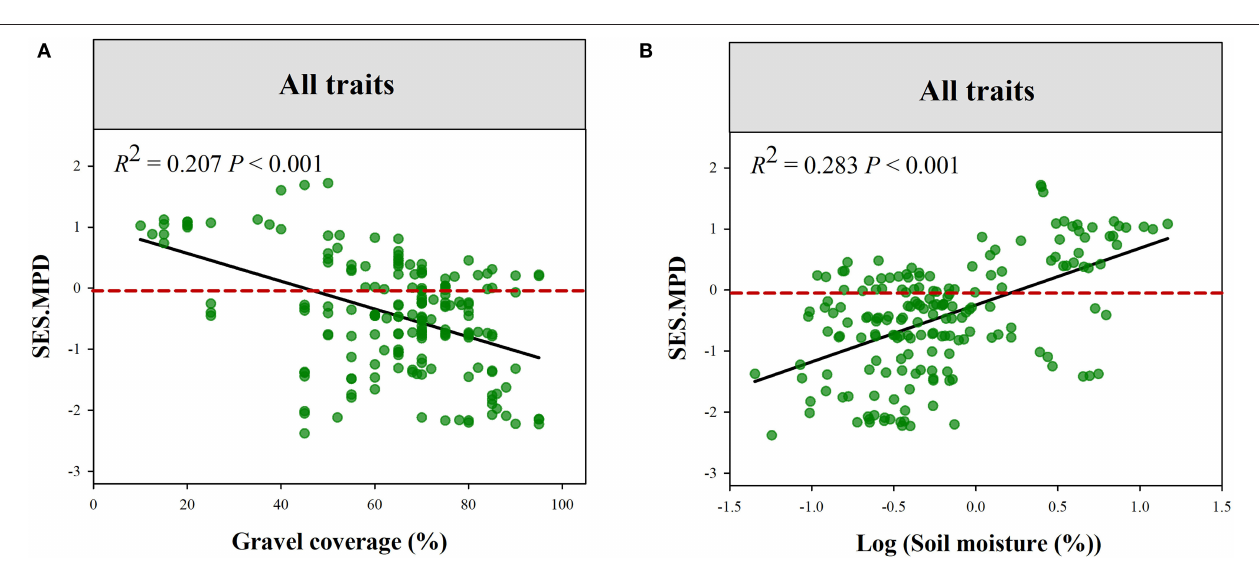
FIGURE 6 | Variations in the standard effect size of functional MPD (all traits combined) along the gradients of Gravel (A) and SM (B) . GC, gravel coverage; SM, soil